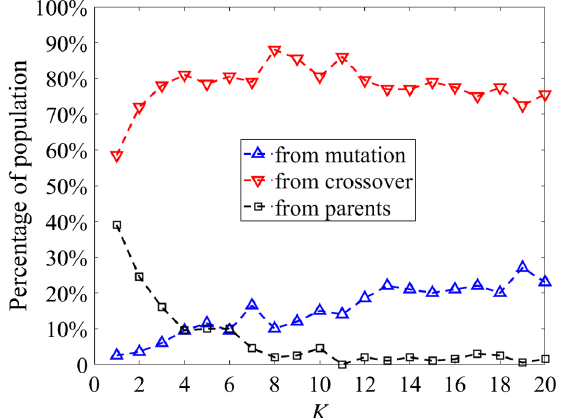
FIG. 7. The origins of individuals in the 11th generation of optimizing ZDT2 with the NBMOGA. The K parameter in the X axis represents different numbers of offspring generated with the NBMOGA. The blue, red, and black markers represent individ- uals originated from mutation, crossover, and copies of parents based on the solutions of the 10th generation, respectively.